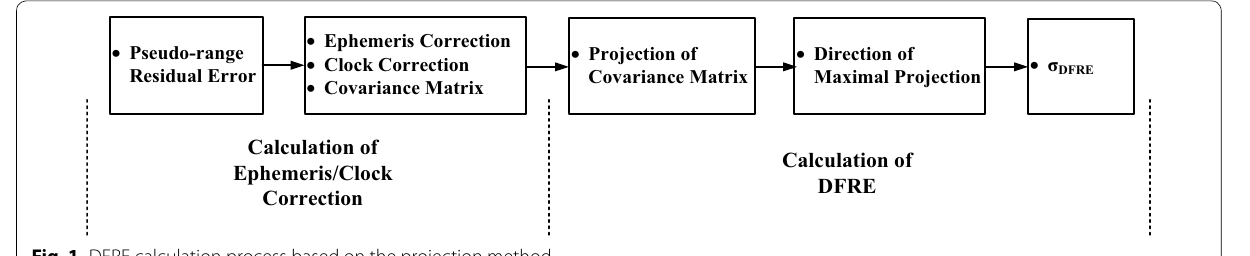
Fig. 1 DFRE calculation process based on the projection